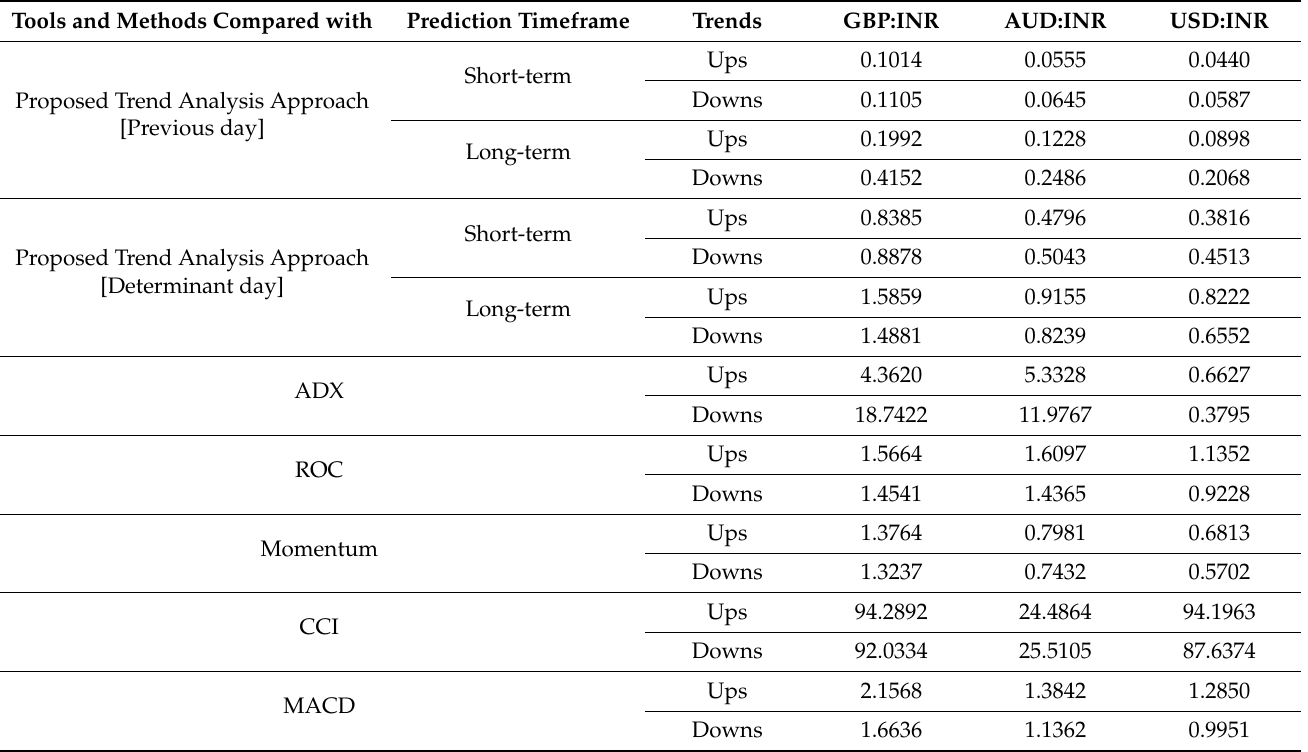
Table 9. Average units up and down (return results) observed for three currency pairs.